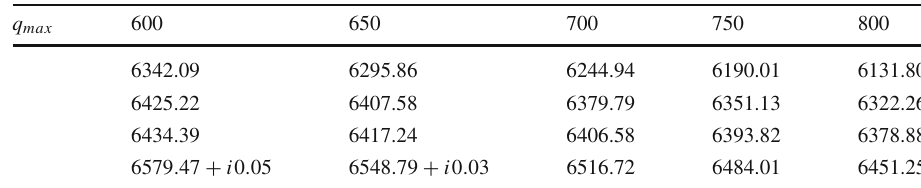
Table 22 The poles in the J P = 1 / 2 − , 3 / 2 − sector from the vector-baron interaction (all units are in MeV)